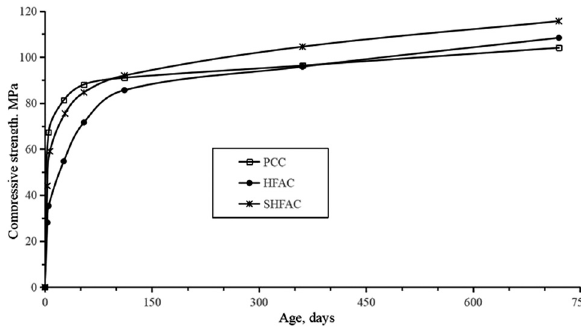
Figure 14: Development of the compressive strength versus age [ 136 ] .